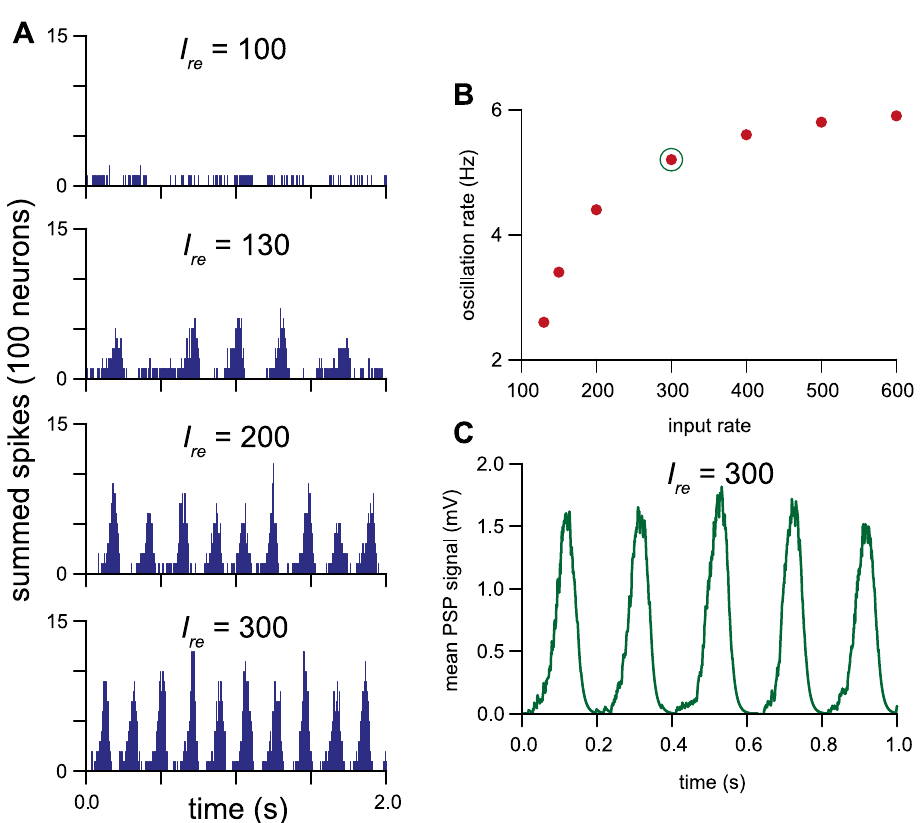
Fig 8. Excitatory network functioning as a signal generator. A network of 100 slow HAP neurons with esyn (similar to esyn 1 = 0.7 in a 50 neuron network) tested with increasing rates of random input signal. (A) Summed activity of the neurons in the network, in 1-ms bins. As the input rate increases, a rhythmic population signal appears. (B) The rhythmic signal increases in oscillation frequency over a range from ~2.5 to 6 Hz as the input rate increases. (C) The green trace simulates the average postsynaptic signal generated by the neurons in the network in the condition indicated by the green circled dot in B